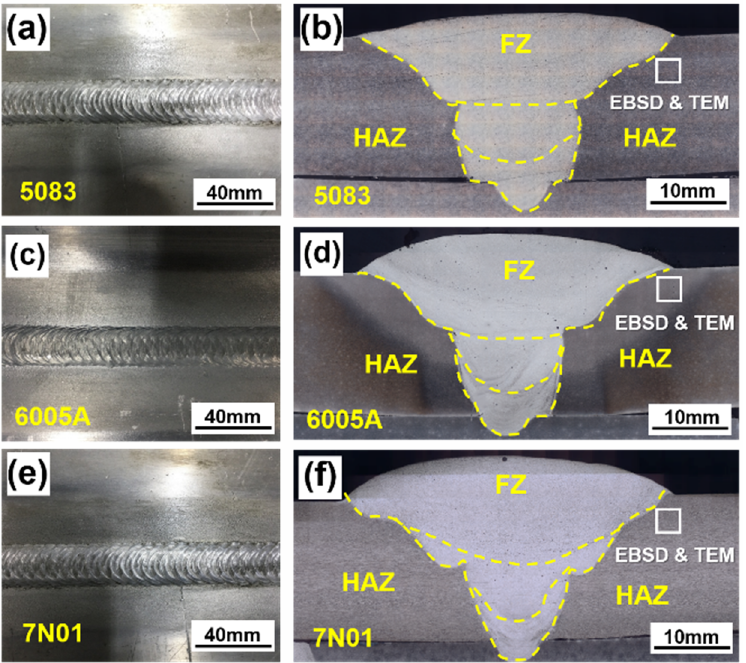
Figure 3. The weld appearance and cross section of welding joints: ( a , b ) for 5083; ( c , d ) for 6005A; ( e , f ) for 7N01. ( e , f ) for